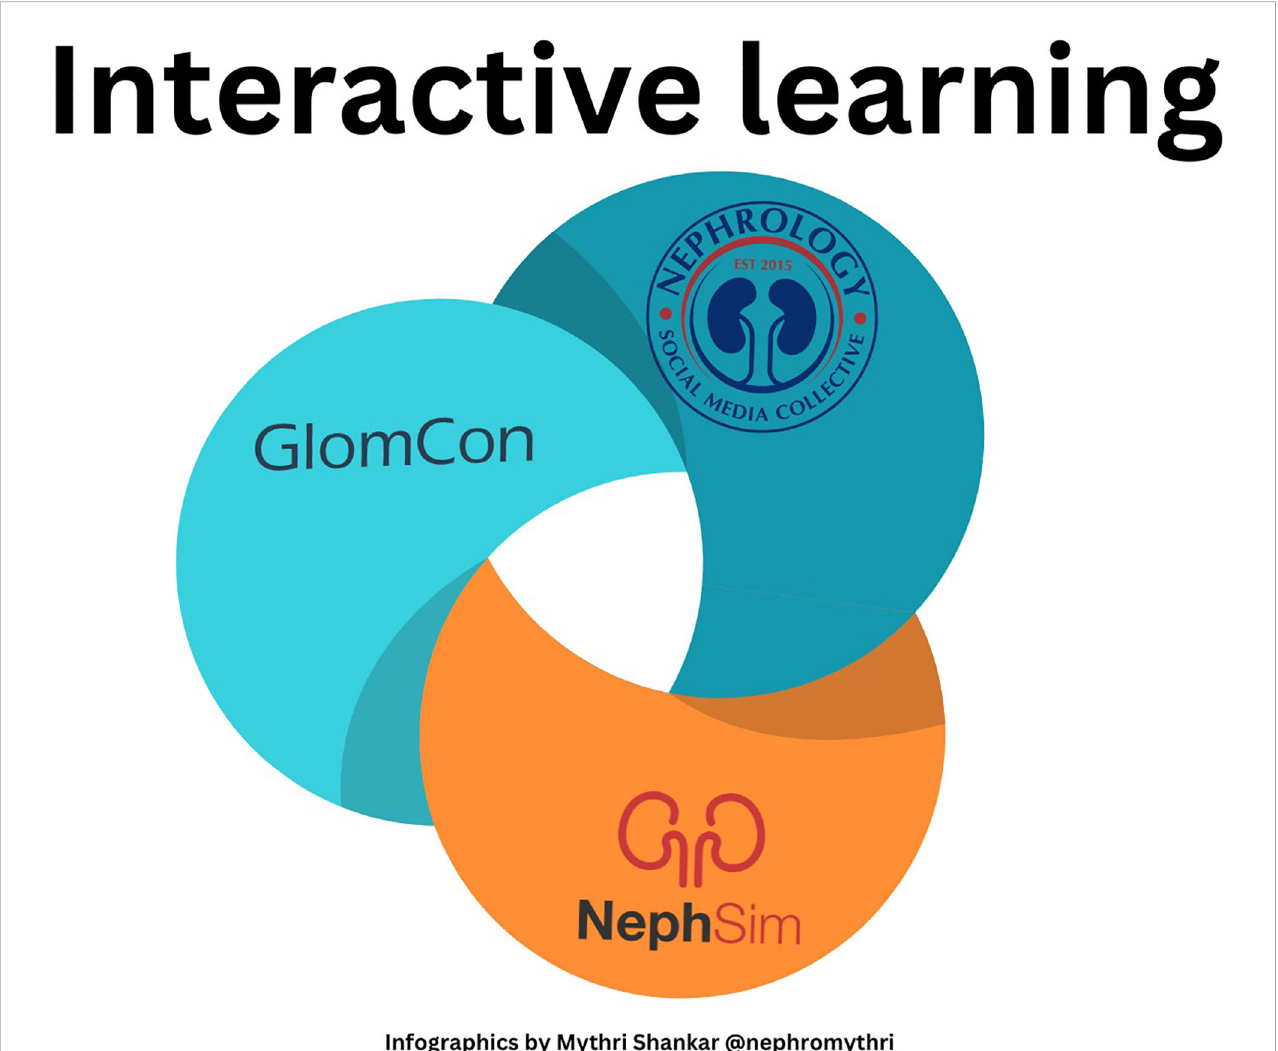
FIGURE 2 Interactive